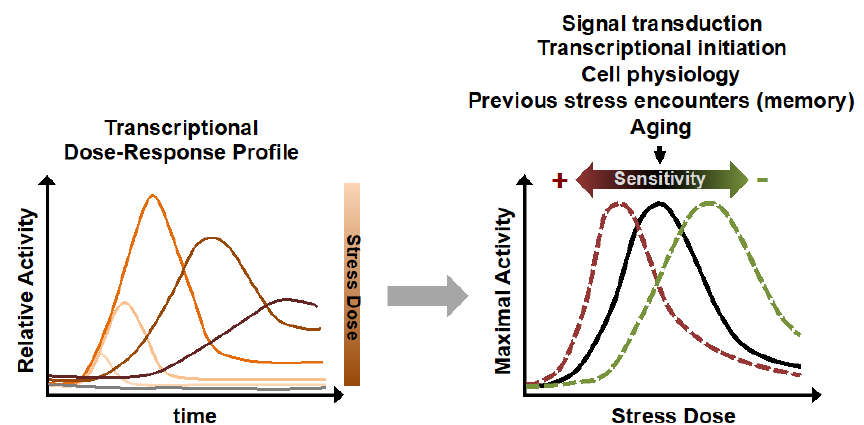
Figure 2. Transcriptional dose–response profiles and their modulation. Continuous monitoring of gene expression quantifies the response of a cell population for a specific gene at any possible stress dose (dose–response (DR) profile, depicted on the left). The responsiveness of gene expression over a stress gradient can dynamically change, as shown on the right. For different genes, the sensitivity of the dose–response might depend on differential signal transduction or on the ability of each gene to engage in active transcription. The same gene might show different DR profiles in cells with altered physiology, different age, or after repeated stress responses.